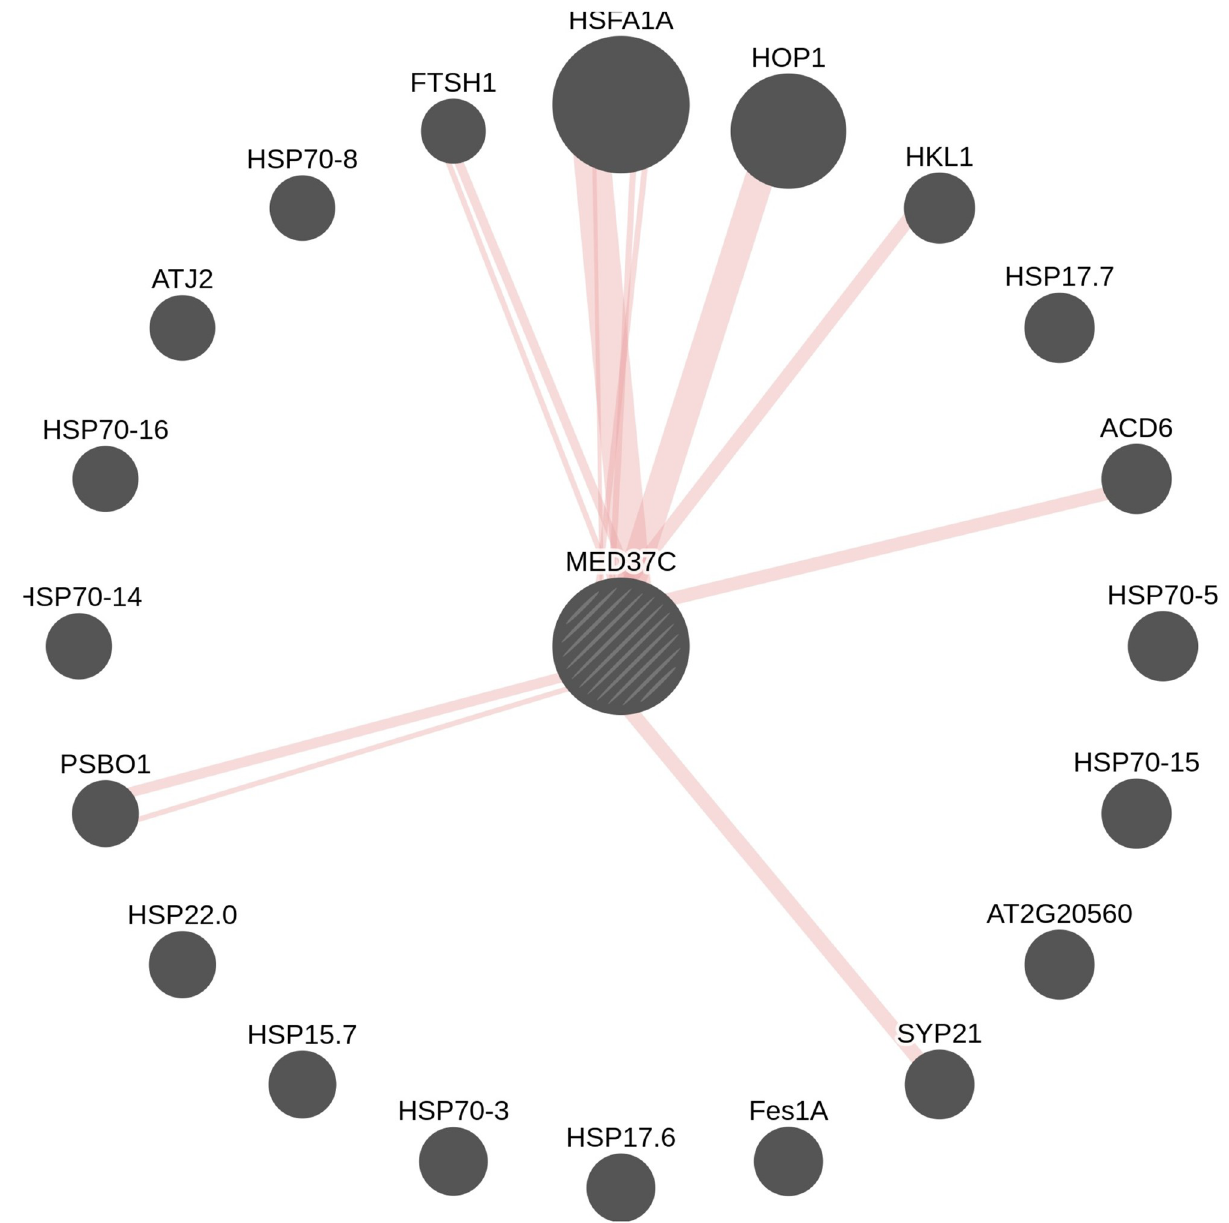
Fig 8. Protein-protein interaction map of the gene MED37C. Physical interactions shown in the form of edges (Thicker the edge, greater the number of experiments for which interactions were ascertained).